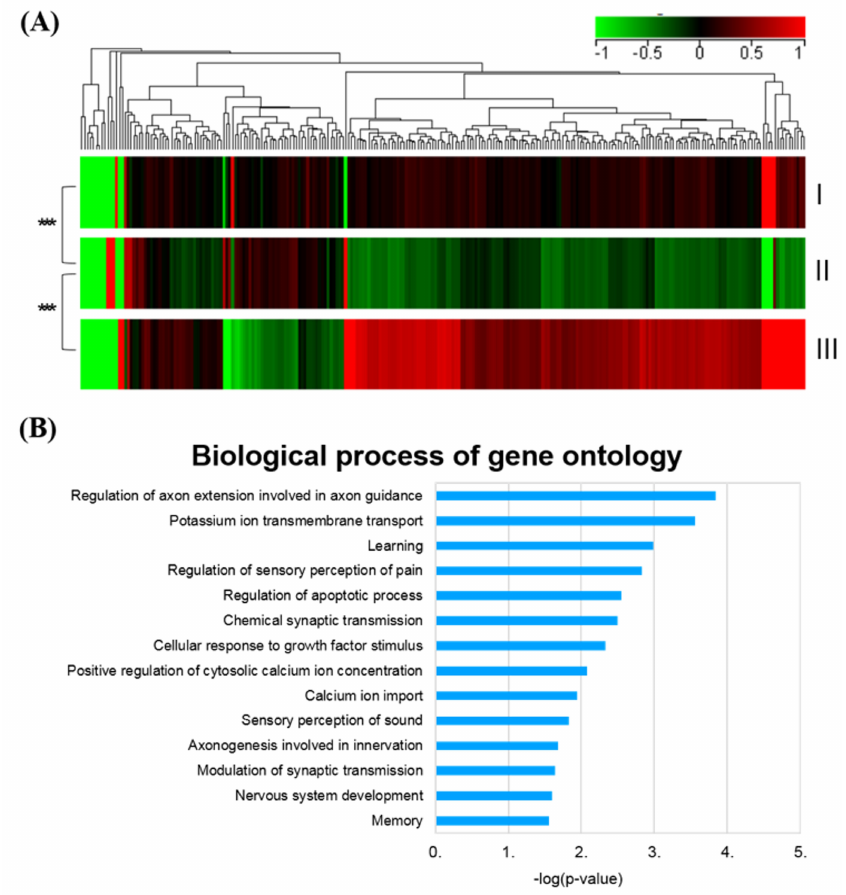
Figure 5. Heat-map analysis demonstrating the expression profiles of the di ff erentially regulated genes in the rotenone-induced PD model with or without SHED-CM treatment. ( A ) Gene expression levels